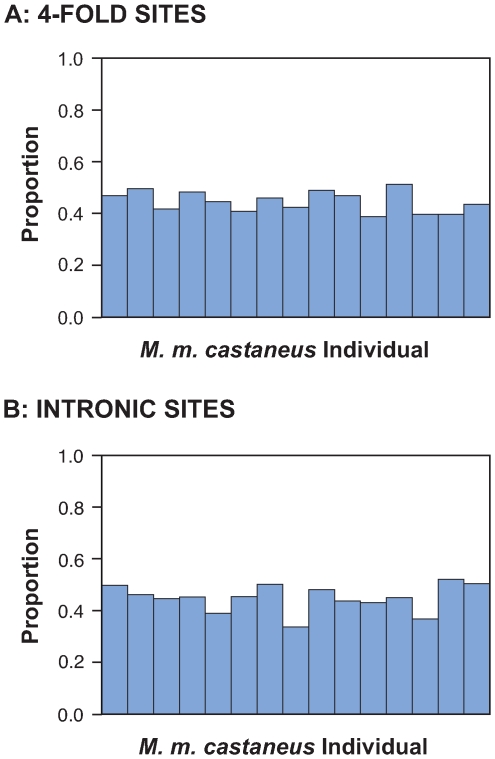
Proportion of ancestry assigned to population 1.Assuming K = 2 using 82 (4-fold degenerate sites, (A)) or using 84 (intronic sites, (B)) unlinked SNP loci. Each column represents one of the 15 M. m. castaneus individuals.